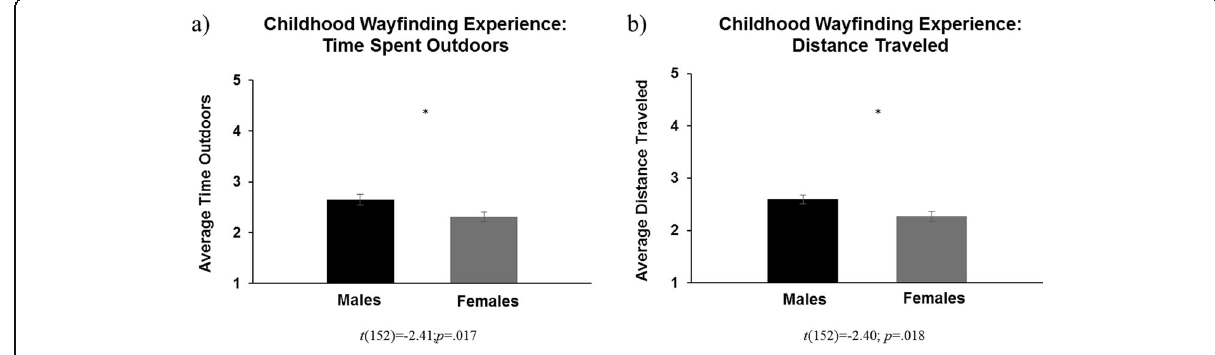
Fig. 1 Sex difference in time spent outdoors ( a ) and distance traveled ( b ) between 6 and 15 years of age. * p < .05